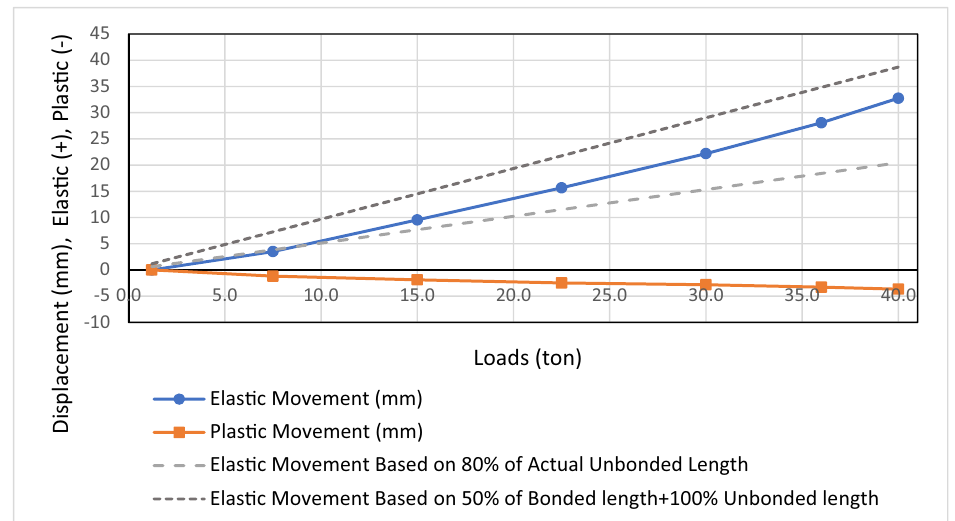
Figure 14: Load – elastic and plastic displacements for anchor